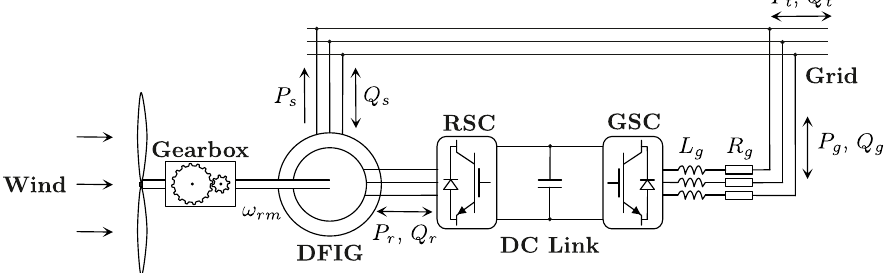
Figure 1. Structure of a doubly-fed induction generator (DFIG)-based wind